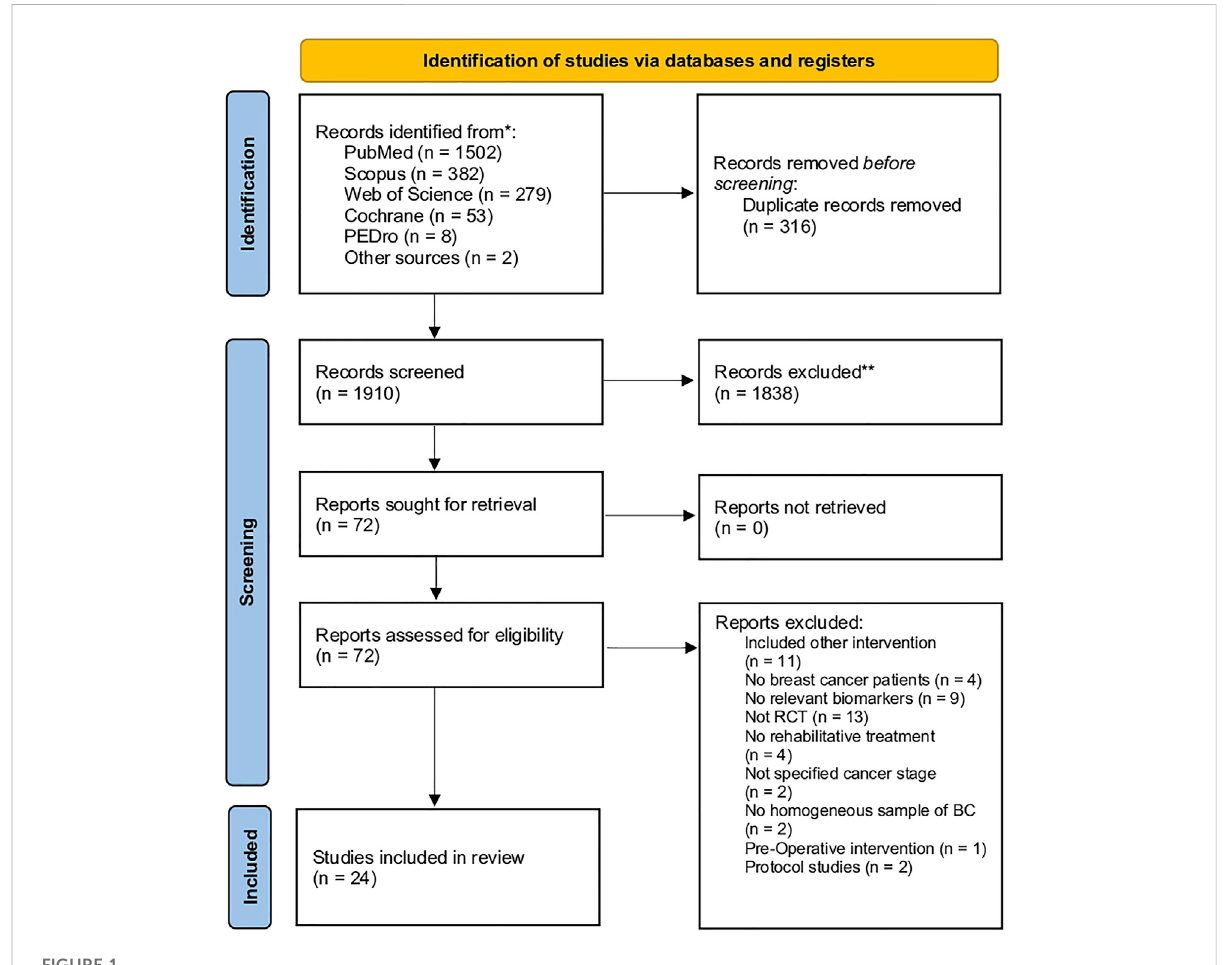
FIGURE 1 PRISMA 2020 fl ow